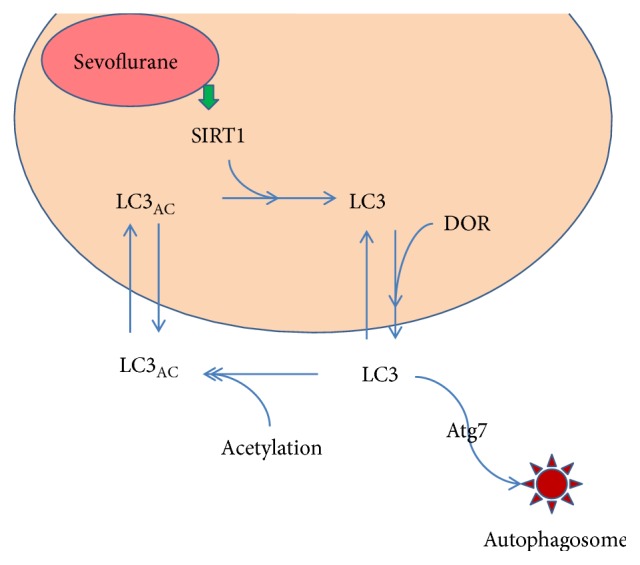
Autophagy pathway of SIRT1/LC3.